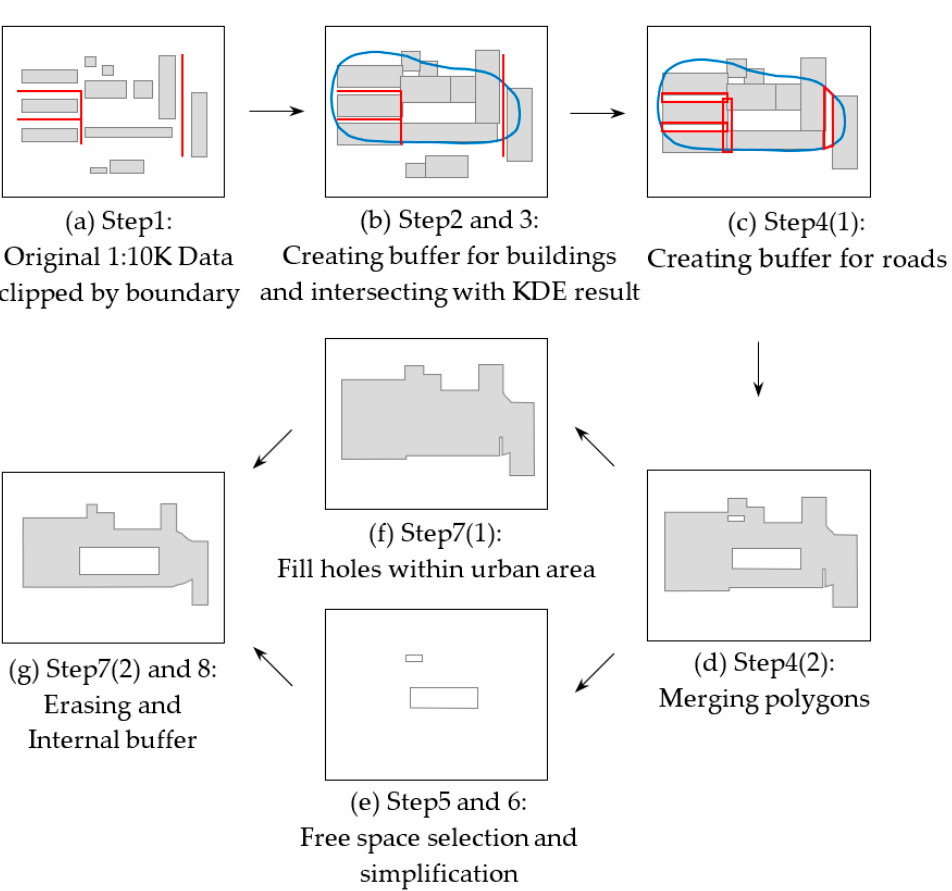
Figure 3. The 1:10K to 1:50K generalization model (it should be noted that the steps in the figure are consistent with those in Figure 7 in Section 2.2.3; a detailed explanation is given in Section 2.2.3): ( a )